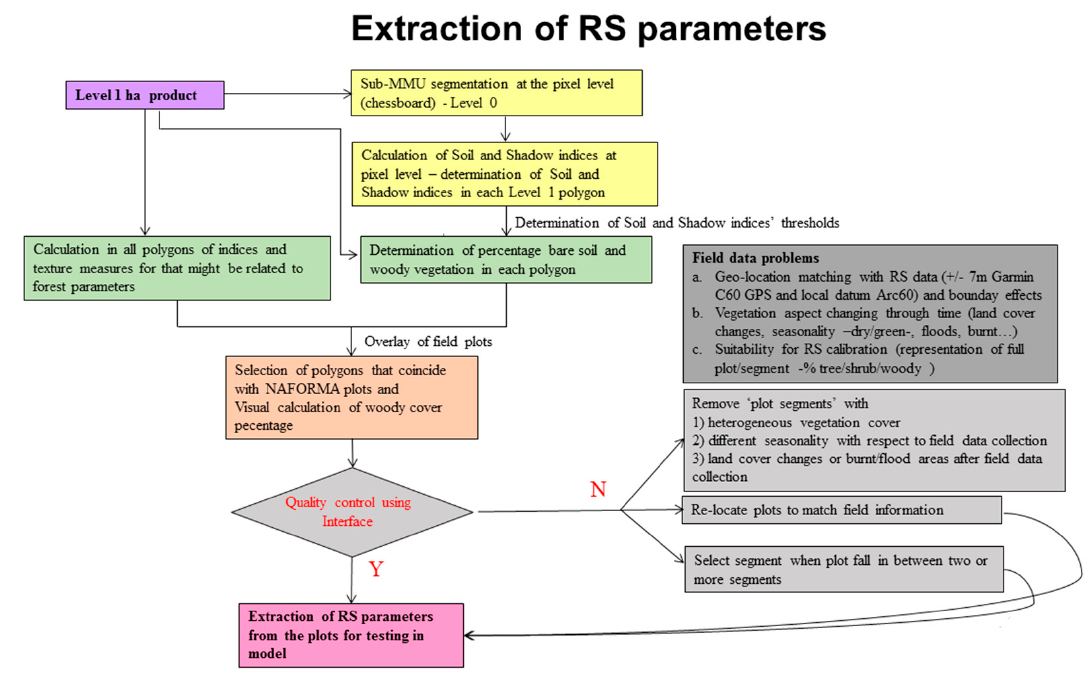
Figure 4. Data extraction scheme.